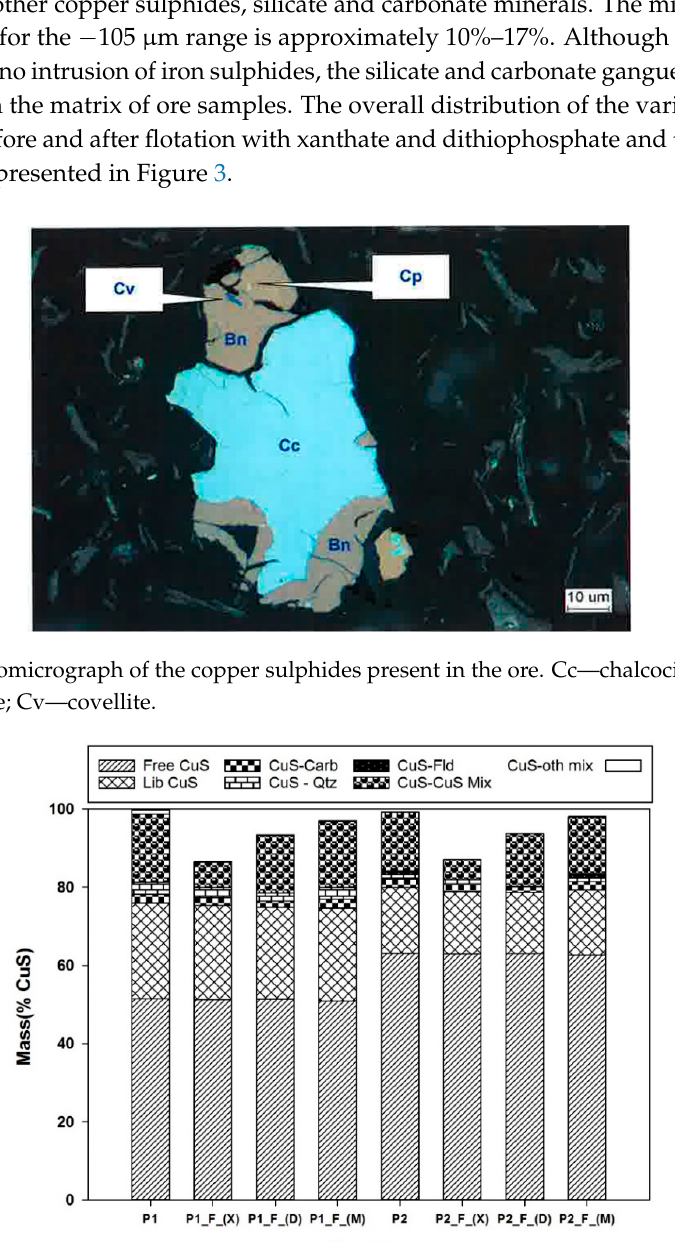
Figure 3. The distribution of various associations of copper sulphides in the Old West (N-OW; P1) and Nussir North East (N-NE; P2) samples at collector concentration 3 × 10 − 5 M and pH 8.2. P1 and P2—Feed; F—Flotation product; X—sodium isobutyl xanthate (SIBX); D—disecondary butyl dithiophosphate (DBD); M—SIBX:DBD = 1:1 ratio (Liberated: >80% liberation; Free: Fully liberated;